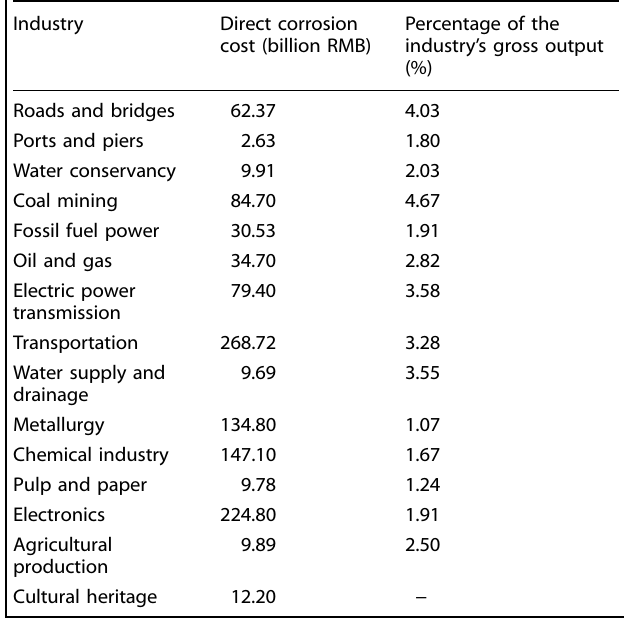
Table 9. The direct costs of corrosion in different industries in China, in